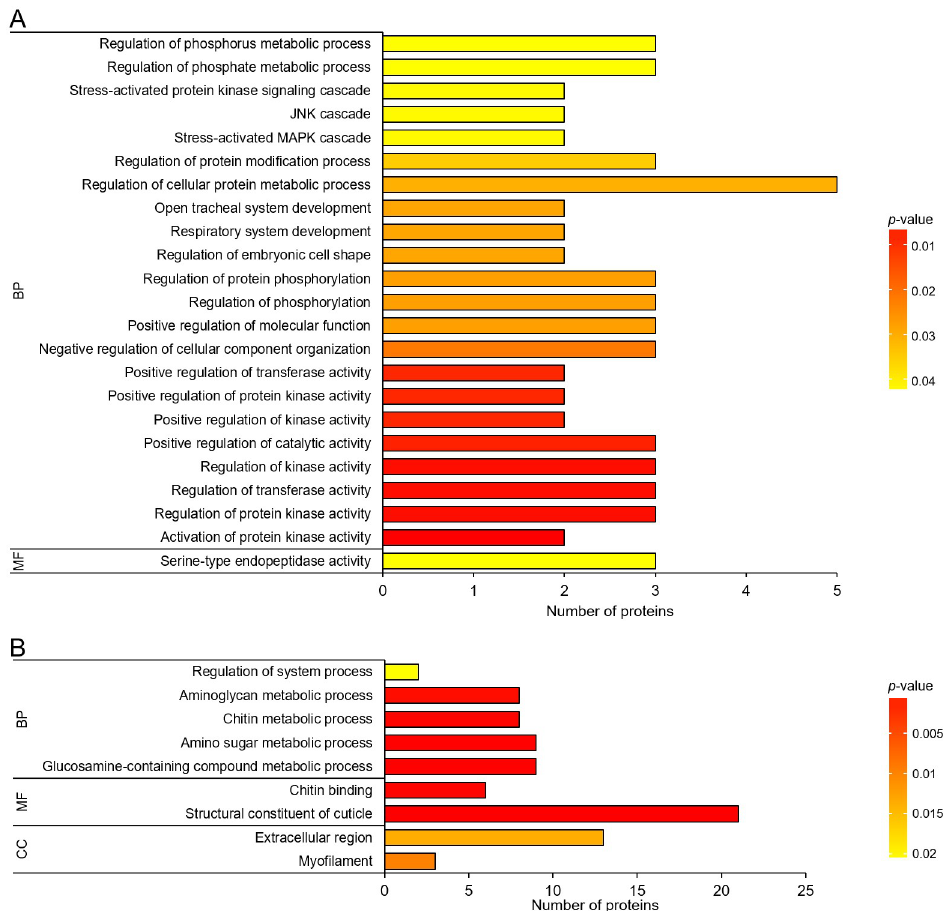
Fig 5. Gene ontology (GO) enrichment analysis of differentially abundant proteins (DAPs) between non- diapause-(ND) and diapause-destined (D) pupae of Bactrocera minax . (A) GO enrichment in ND1 vs D1 comparison. (B) GO enrichment in ND15 vs D15 comparison. GO terms fall into three main categories, cellular component (CC), molecular function (MF), and biological process (BP). The color gradient corresponds to the magnitude of p value.